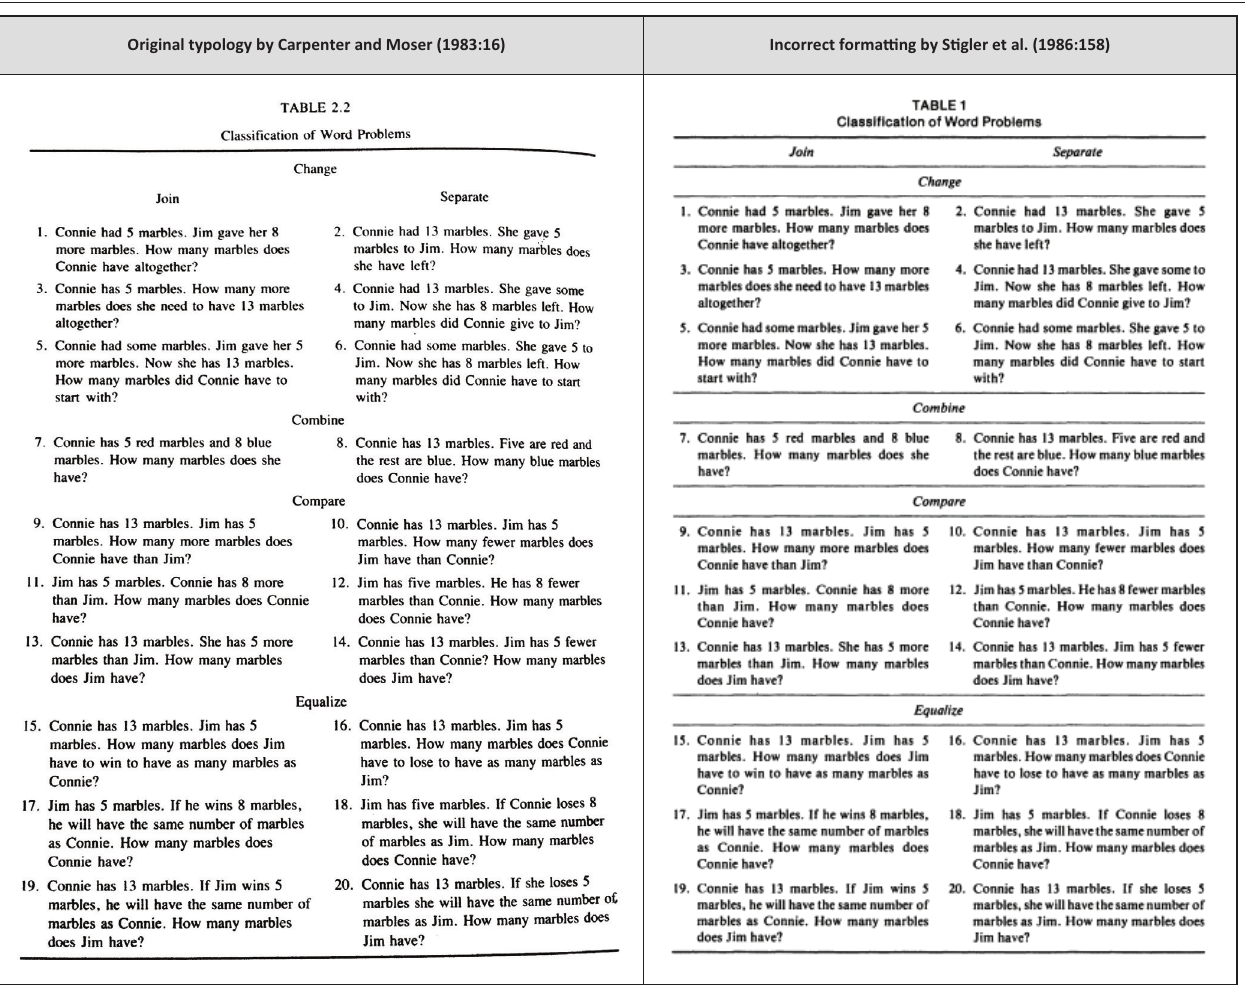
FIGURE 10: Tables showing ambiguous and incorrect formatting for ‘Join’ and ‘Separate’